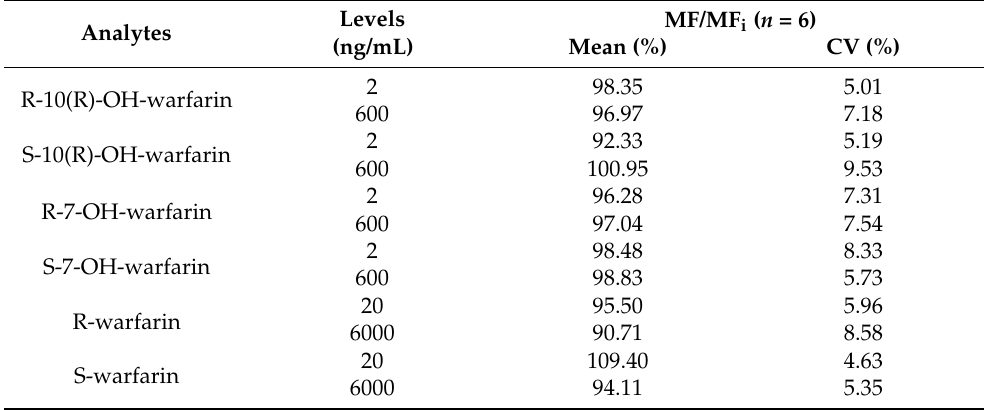
Table 3. Matrix effect of warfarin and hydroxywarfarins enantiomers in rat